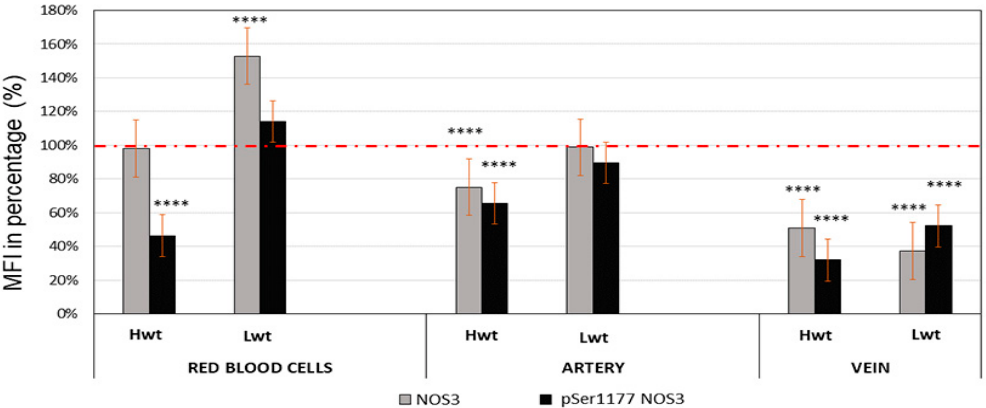
Figure 1. Quantification of the NOS3 expression and its activation level at pSer1177 residue. Mean fluorescent intensity (MFI) were expressed in the percentage of the subsequent High birthweight twin (Hwt) and Low birthweight twin (Lwt) population in comparison to their age and weight matched singletons High birthweight singleton (Hws) and Low birthweight singleton (Lws) as controls. The red dotted line represents the control intensity level at 100% within the both umbilical cord vessel endothelium and isolated fetal arterial cord red blood cells (RBCs). **** Marks the significant differences based on the Newman-Keuls multiple comparison test at p < 0.0001.